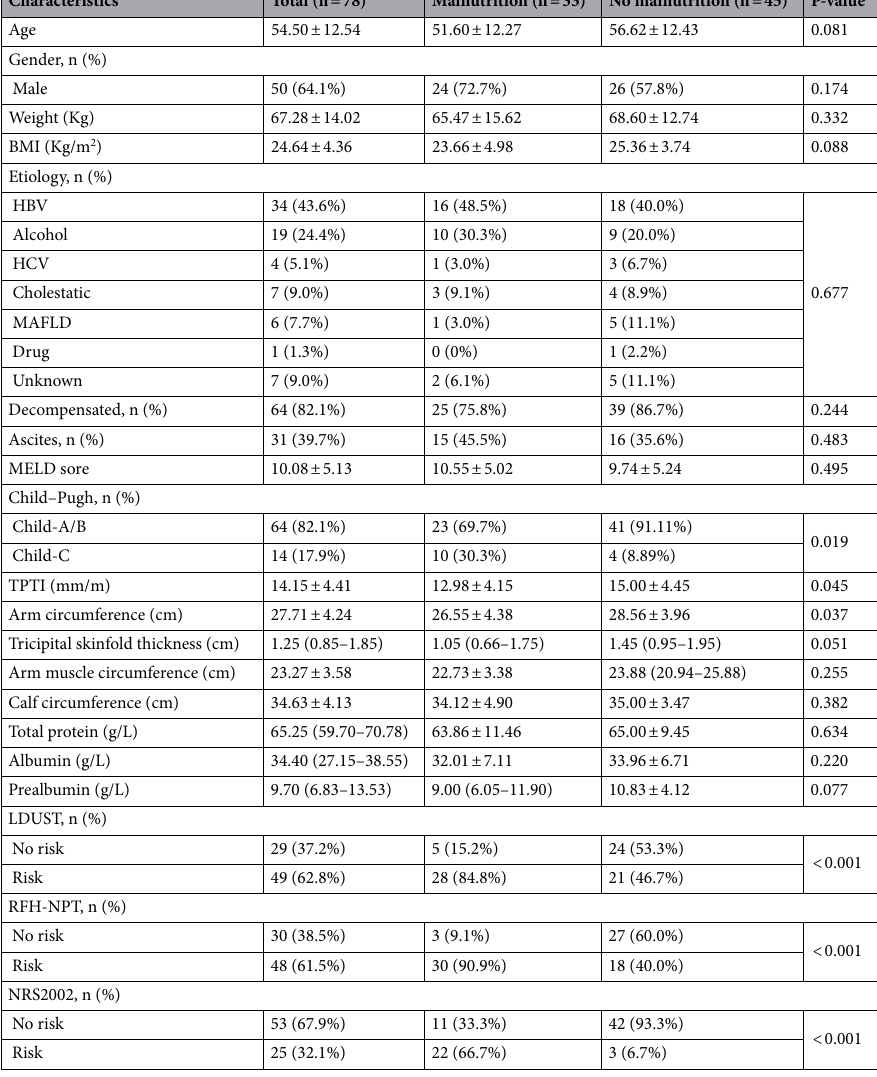
Table 1. Baseline data of total patients and per nutritional state, stratified by GLIM criteria. BMI body mass index, HBV hepatitis B virus, HCV hepatitis C virus, MAFLD metabolic dysfunction-associated fatty liver disease, MELD the model for end-stage liver disease, TPTI transversal psoas thickness index, LDUST liver disease undernutrition screening tool, RFH-NPT royal free hospital-nutritional prioritizing tool, NRS2002 nutritional risk screening